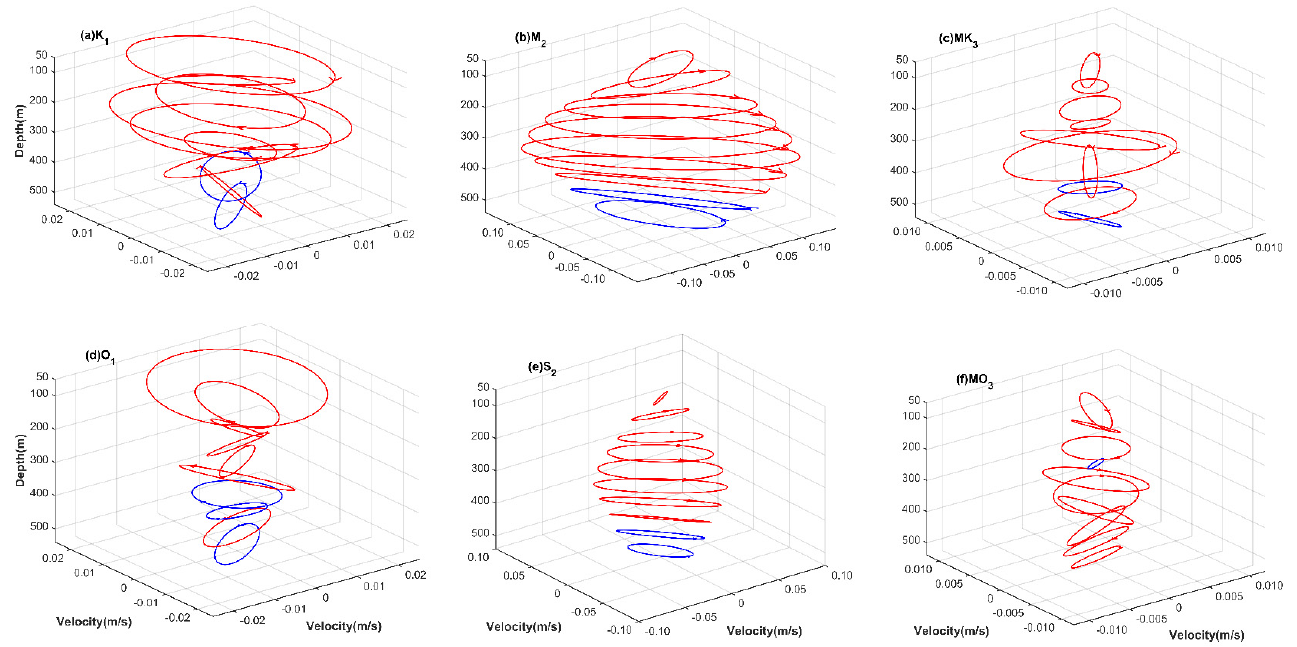
Figure 9. Tidal current ellipses of the major baroclinic tidal constituents of ITs (D1, D2, and D3) over the OP3. ( a – f ) denote the K 1 , M 2 , MK 3 , O 1 , S 2 , and MO 3 tidal constituent, respectively. The red ellipses denote clockwise rotation, and the blue ellipses denote counterclockwise rotation.